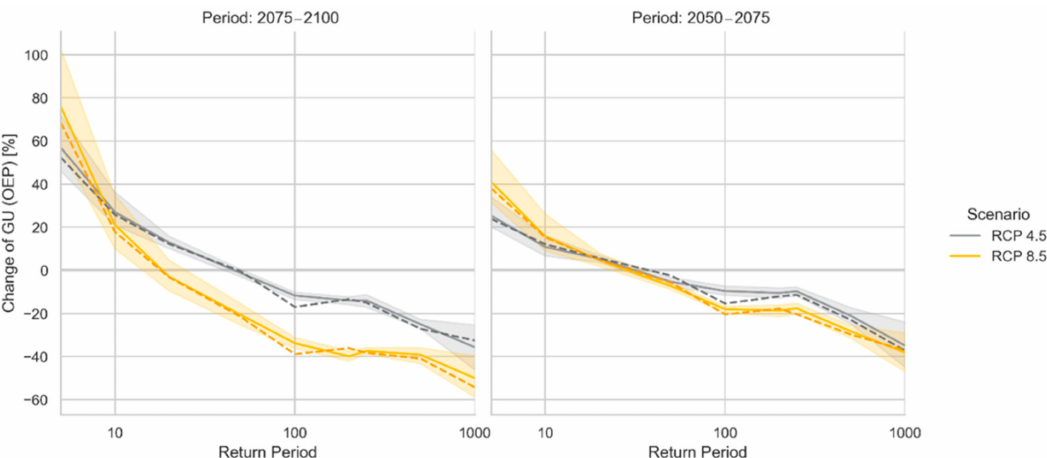
Figure 10. Percentual change of GU (OEP) for the two periods and RCP scenarios. The solid line with a filled area is the mean value with a 95 percent confidence interval based on the portfolios of the seven largest insurers. The dashed line indicates the aggregated market portfolio (postal code level only) comparison.